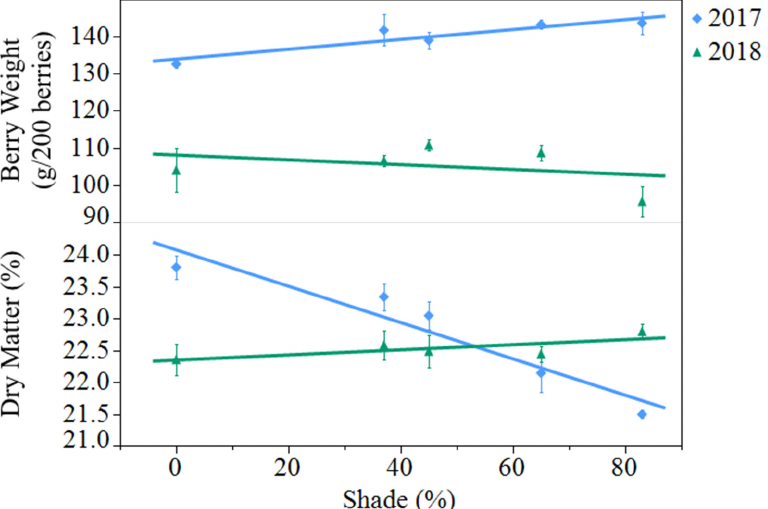
Figure 1. Effect of artificial shade treatment on berry fresh weight and dry matter of black cur- rants ( Ribes nigrum c.v ‘Consort’) grown in Urbana, IL in 2017 and 2018. Data are presented as the mean ± standard error of n = 4 replicates. Regression equations (where x = percent shade) were as follows: berry weight (2017) = 134.0 + 0.1331x, r 2 = 0.38, p value = 0.0040; berry weight (2018) = 108.1 − 0.0648x, r 2 = 0.05, p value = 0.3360; berry dry matter (2017) = 24.1 − 0.0286x, r 2 = 0.77, p value < 0.0001; berry dry matter (2018) = 22.4 + 0.0040x, r 2 = 0.09, p value =